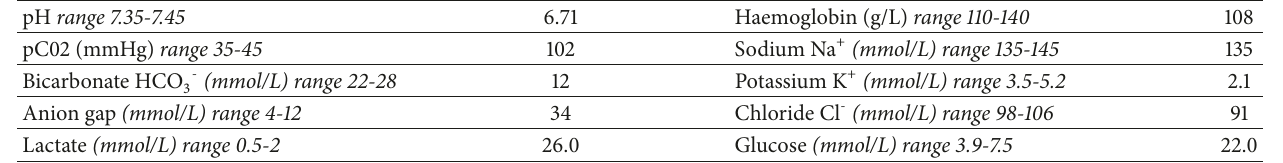
Table 2: Venous blood gas (VBG) on arrival to the emergency department.